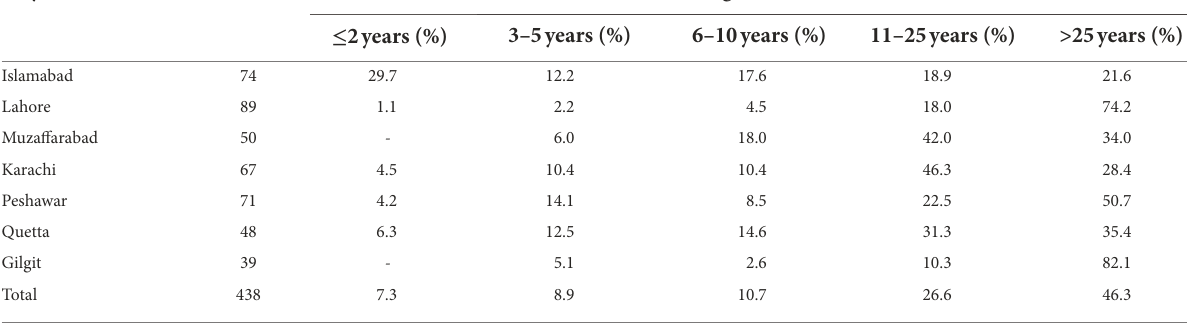
TABLE 2 Experience of peri-urban dairy farmers in different Pakistani cities. City